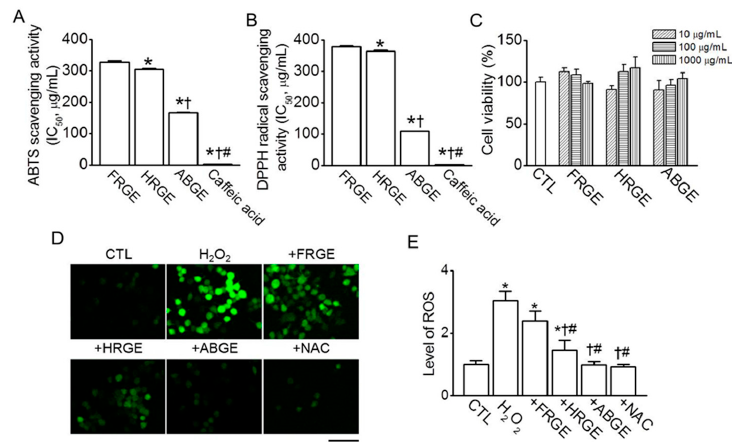
Figure 1. Antioxidant activity of garlic extracts. ( A ) ABTS and ( B ) DPPH radical scavenging activities of garlic extracts. Each bar represents the half maximal inhibitory concentration (IC 50 ). * p < 0.05 compared with the FRGE treatment. † p < 0.05 compared with the HRGE treatment. # p < 0.05 compared with the ABGE treatment; ( C ) Effect of garlic extracts on viability of RAW264.7 cells. Different concentrations of garlic extracts were treated to cells for 24 h; ( D , E ) Effect of garlic extracts on H 2 O 2 -induced ROS generation in RAW264.7 cells. Cells were treated with 100 µ M H 2 O 2 , 1000 µ g/mL garlic extracts, or 3 mM NAC and then stained with H 2 DCFDA to evaluate ROS generation. The ROS levels in the cells were quantified using fluorescence microscopy after 3 h of treatment with the extract. The plus sign (+) represents conditions co-treated with H 2 O 2 . The scale bar represents 50 µ m. * p < 0.05